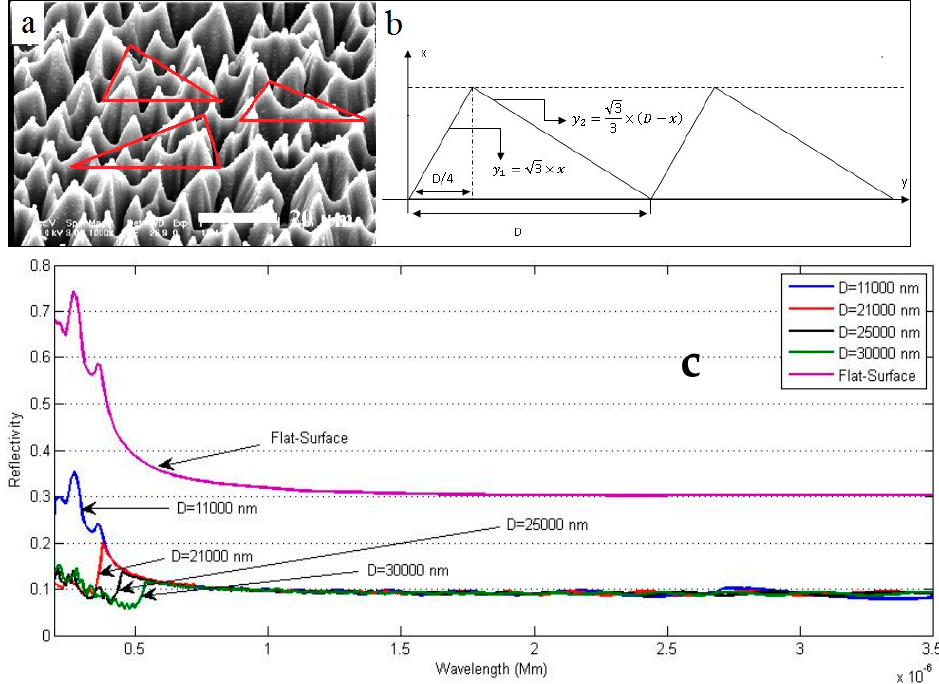
Figure 4. ( a ) Experimental triangular microstructures on Si surface [9], ( b ) Schemes of the microstructure of interest for simulation with programming code, ( c ) Simulation result for microstructures with a periodicity of 11, 21, 25 and 30 μ m. The height of the structures for a typical sample with a periodicity of 30 μ m is set to be ~13 μ m.